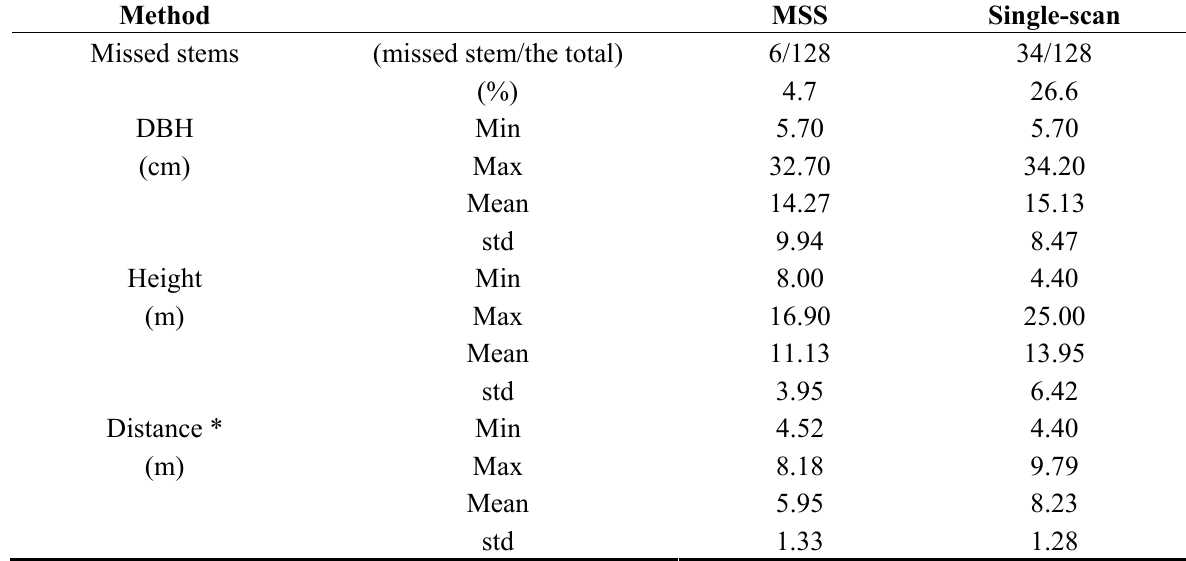
Table 5. The attributes of the stems that were not mapped (omissions) in the point clouds. Method MSS Missed